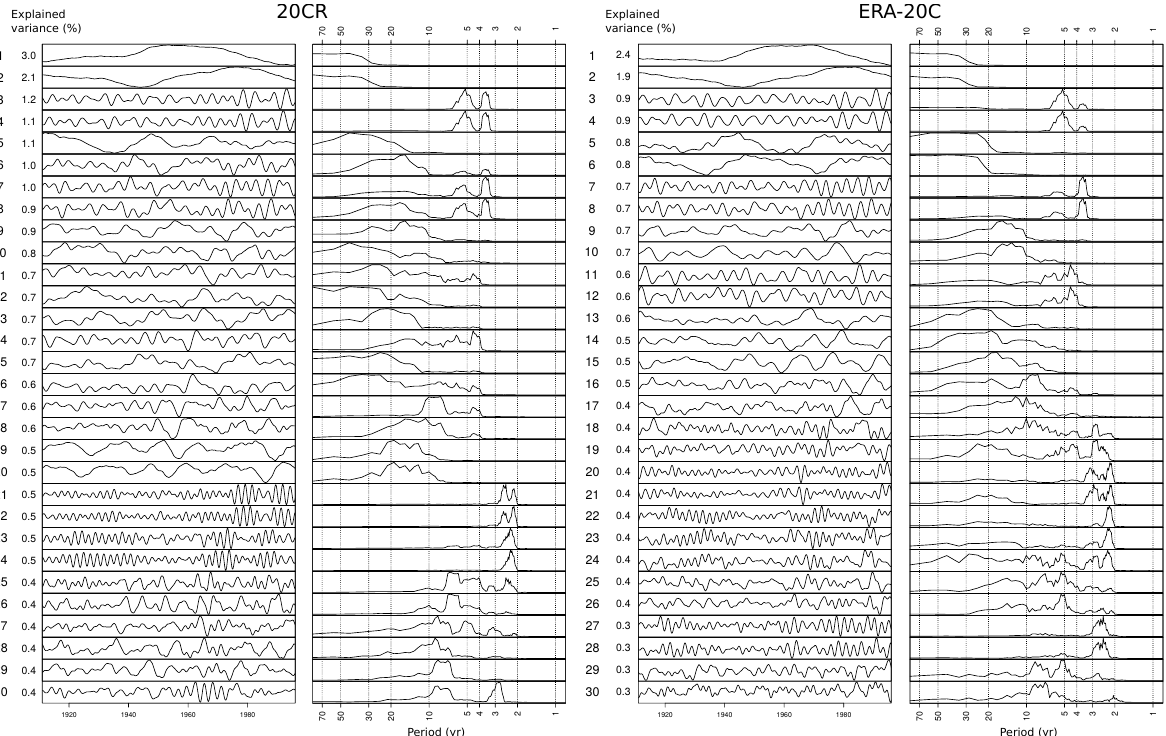
Figure 2. Reanalysis ST-PC time series (columns 1 and 3) of monthly near-surface temperature 1901–2005 and their spectra (columns 2